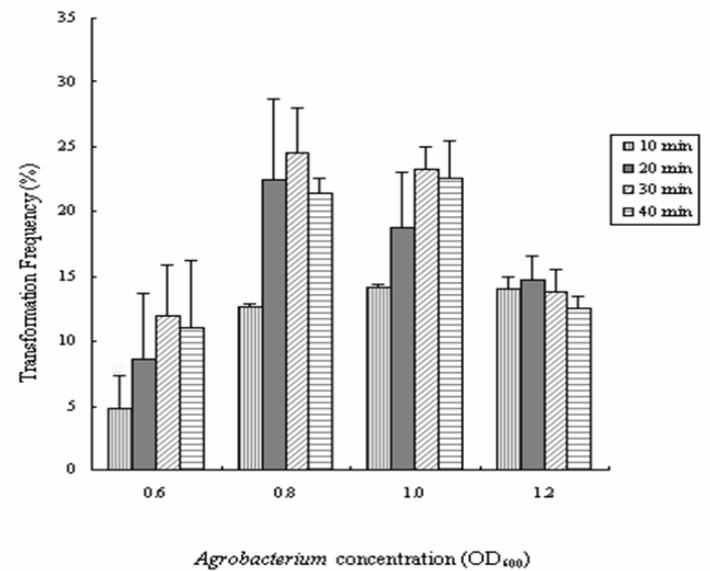
Figure 2. Frequency of transformation of Populus davidiana Dode × Populus bollena Lauche with different Agrobacterium concentrations and infection